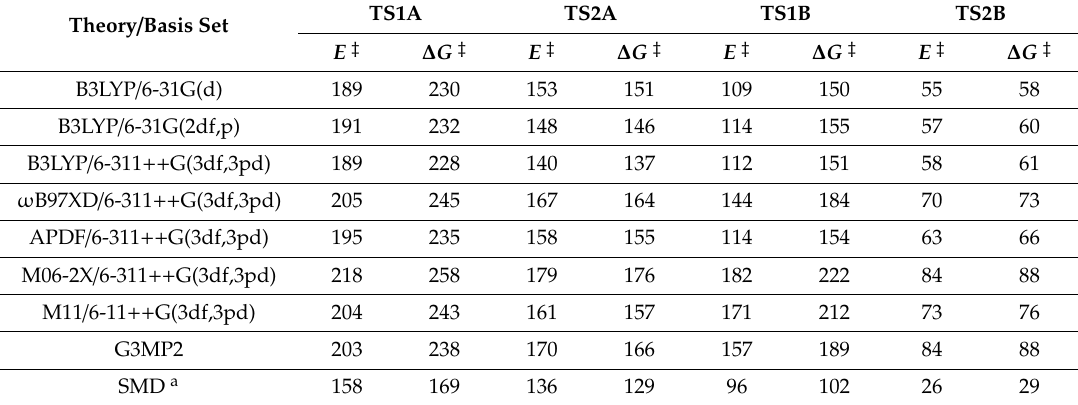
Table 1. Barrier Heights and Gibbs energies of activation (in kJ mol − 1 ) at 298.15 K for Pathways A and B.